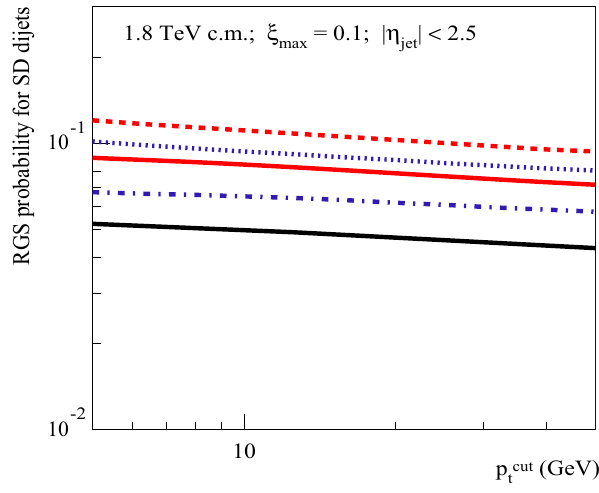
= 20 GeV/c, ξ = 0 . 01 (left) Fig. 16 Energy dependence for p cut SD+ (respectively, dotted and dotted-dashed lines); | η jet | < 2 . 5. The √ max t s = 1 . 8 TeV, ξ max = 0 . 1 (right) of the RGS and p cut t -dependence for downmost solid lines correspond to S 2 factors S 2 and S 2 for SD dijet production, using alternative SD ( eik ) SD ( tot ) parameter tunes: SD- (respectively, dashed and upper solid lines), and